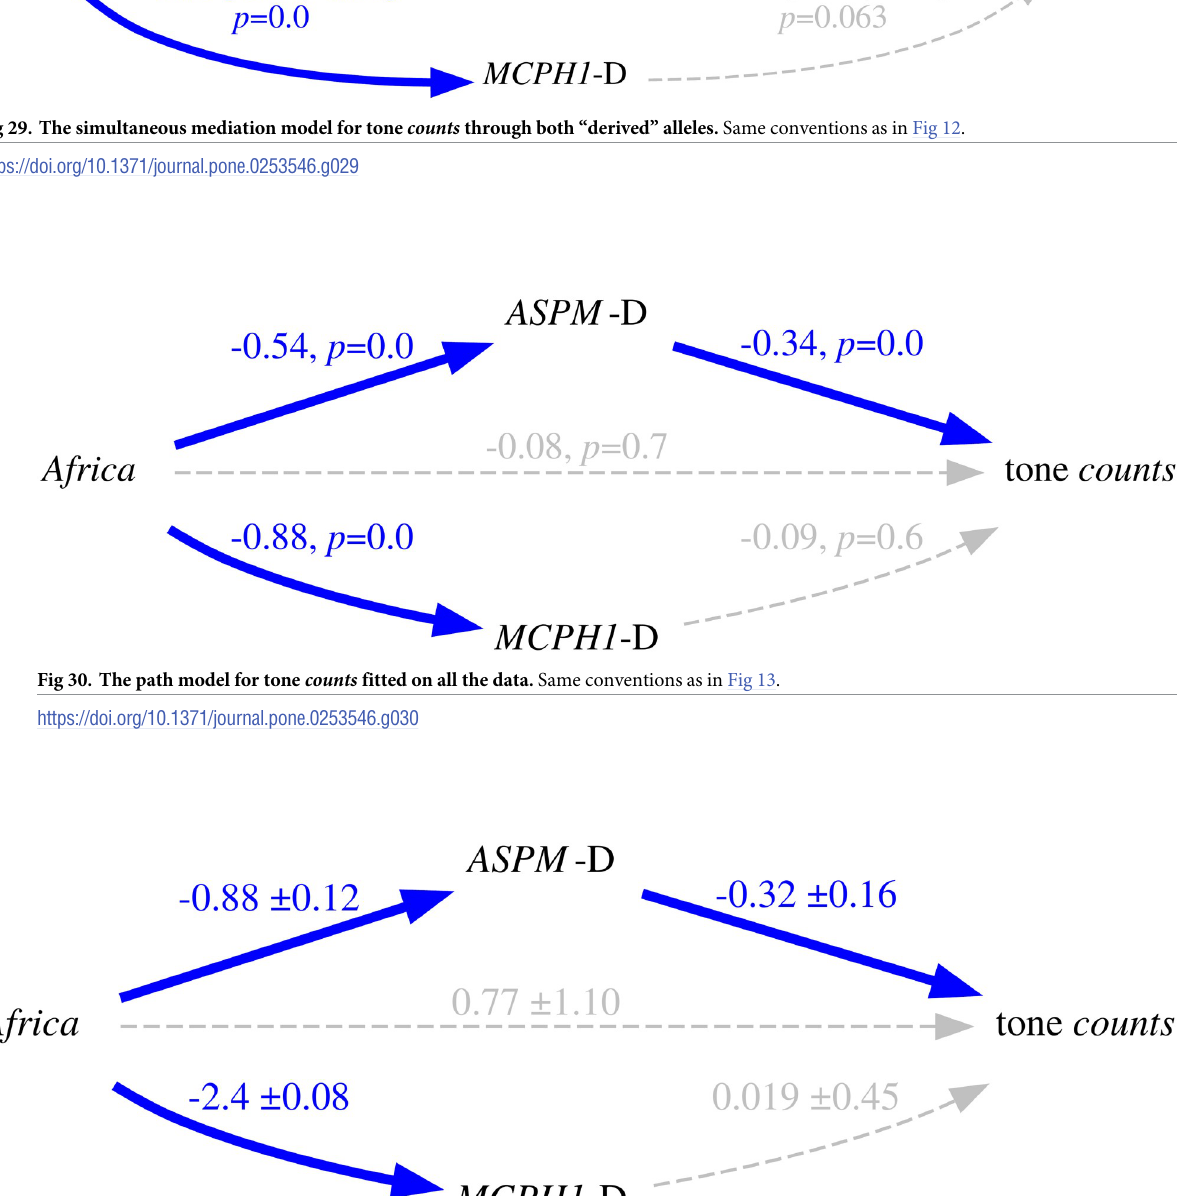
PLOS ONE | https://doi.org/10.1371/journal.pone.0253546 June 30, 2021 47 /